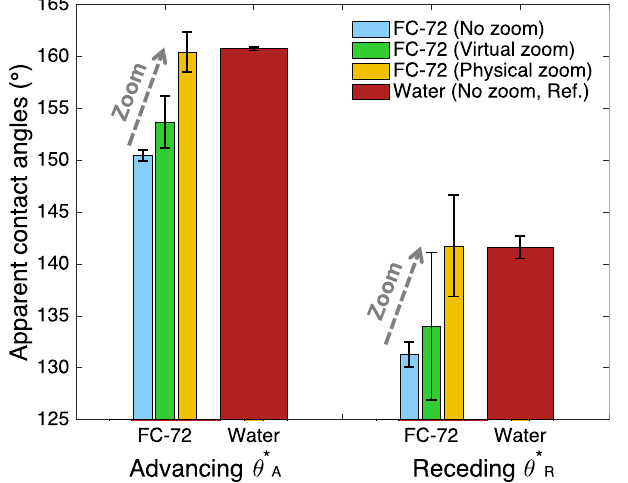
Figure 4. Comparisons of measured contact angles of FC-72 at different zooms with water as a reference. Without zoom, there is ~10° contact angle deviation of FC-72 due to blur that causes an inaccurate meniscus detection. With virtual zoom, the image was digitally scaled but provides fewer points for calculation, leading to more scattered data. With physical zoom, the meniscus was better resolved and showed accurate contact angle while the data scattering was caused by local contact angle variation from a relatively large wavelength of the surface roughness.